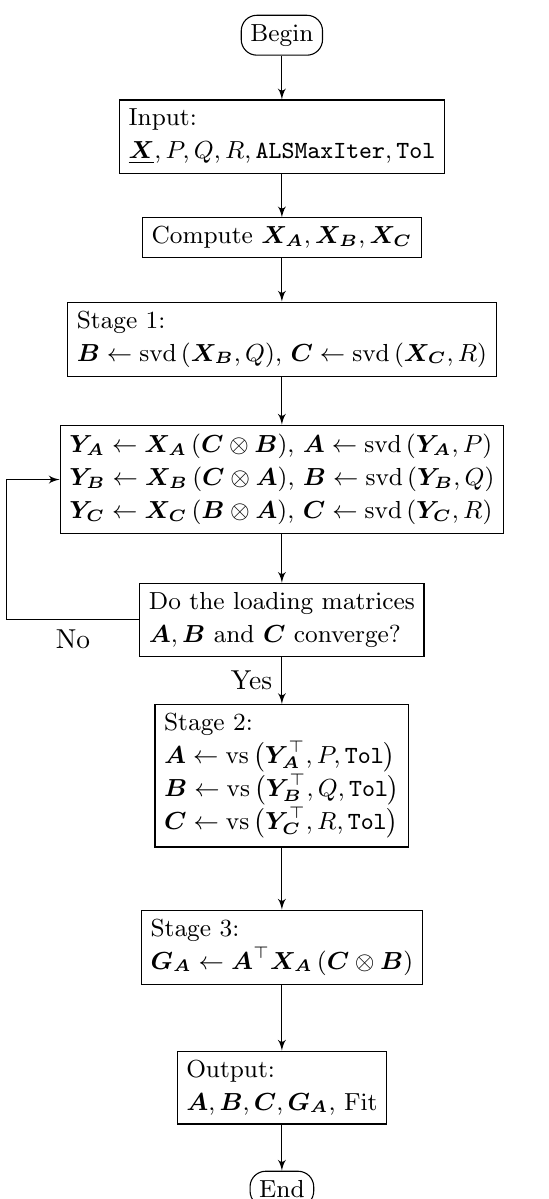
Figure 3. Flowchart of the DisjointTuckerALS algorithm that computes three disjoint orthogonal matrices: A , B , and C